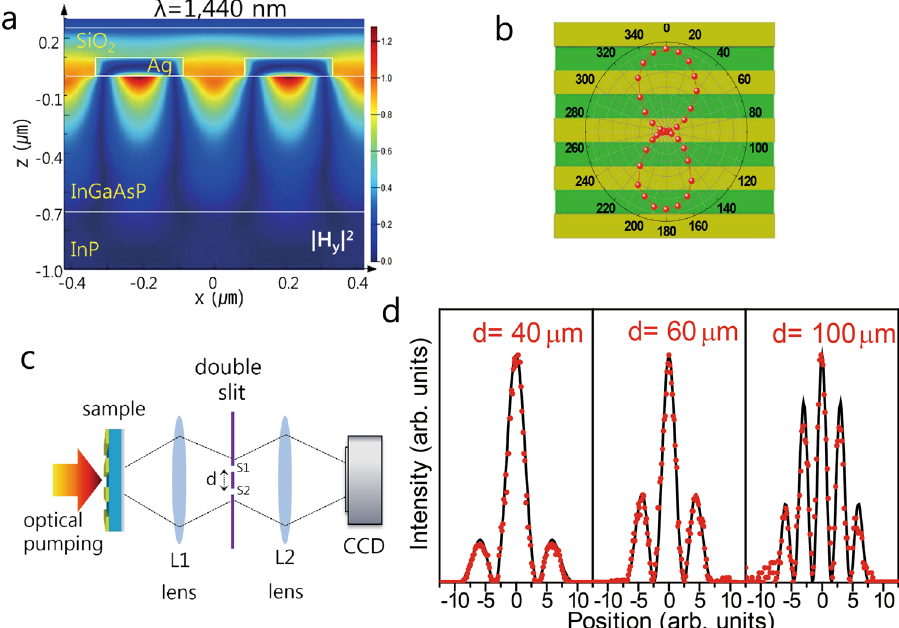
Figure 2. Characteristics of the SP lasing. ( a ) FDTD simulation of the electromagnetic fields at a grating structure with Λ = 420 nm induced by normally incident light at the lasing wavelength (1440 nm, TM polarization). ( b ) Polarization direction analysis of the SP lasing. ( c ) Schematic setup of Young’s double-slit experiment for spatial coherence measurements. ( d ) Diffraction patterns measured with a CCD camera for slit separations of 40, 60, and 100 μ m. The solid lines are fitting curves given by Eq.